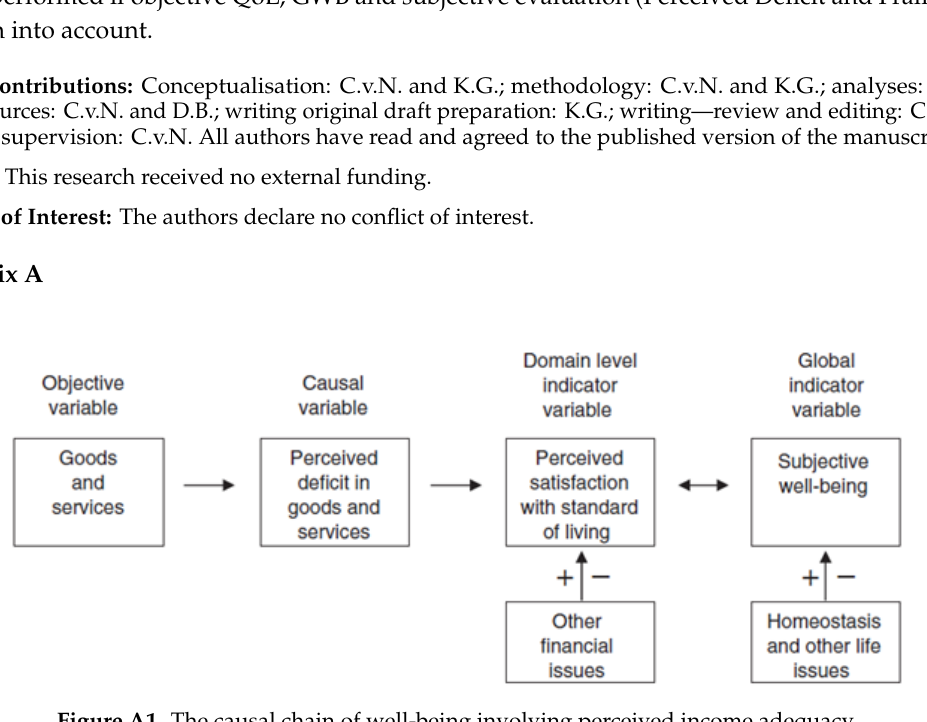
Figure A1. The causal chain of well-being involving perceived income adequacy.